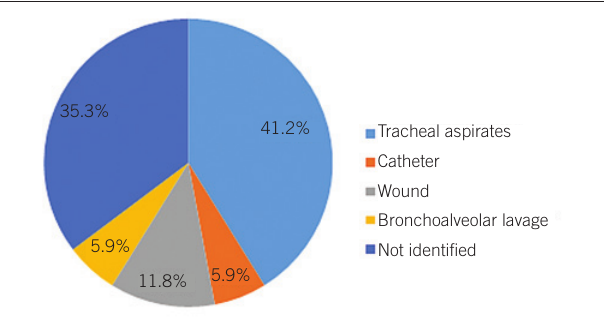
figurE 2 − Percentage of 17 Acinetobacter baumannii isolates from hospital 2 according to the source of specimens